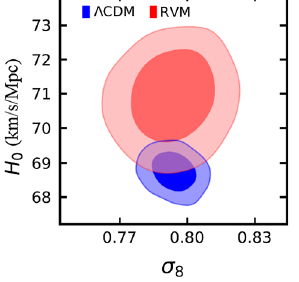
Fig. 4 Comparative contours at 1 σ and 2 σ c.l. in the ( σ 8 - H 0 )-plane corresponding to the RVM and the (cid:2) CDM for the data sets mentioned in the text. It can be seen that the RVM is quite effective in alleviating the H 0 tension and at the same time it reduces the σ 8